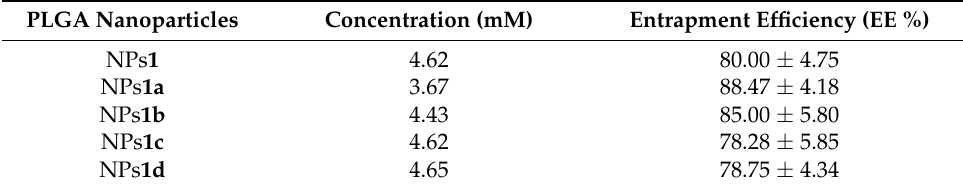
Table 3. Compound concentrations (mM) loaded in PLGA NPs and entrapment efficiency (EE